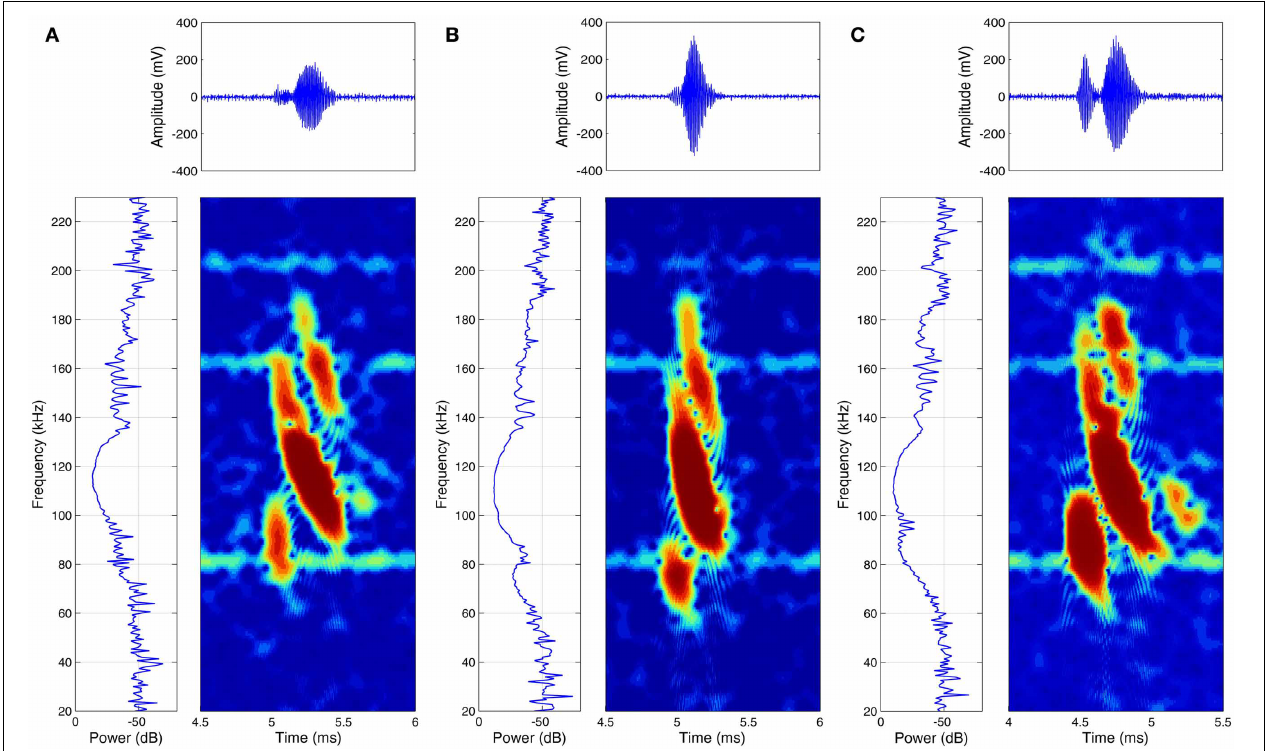
FIGURE 5 | Examples of high-pitched echolocation calls of three specimens of Glossophaga soricina while approaching a feeder. For each specimen (A–C) the power spectrum (left) the spectrogram (right) and the time signal (top) is